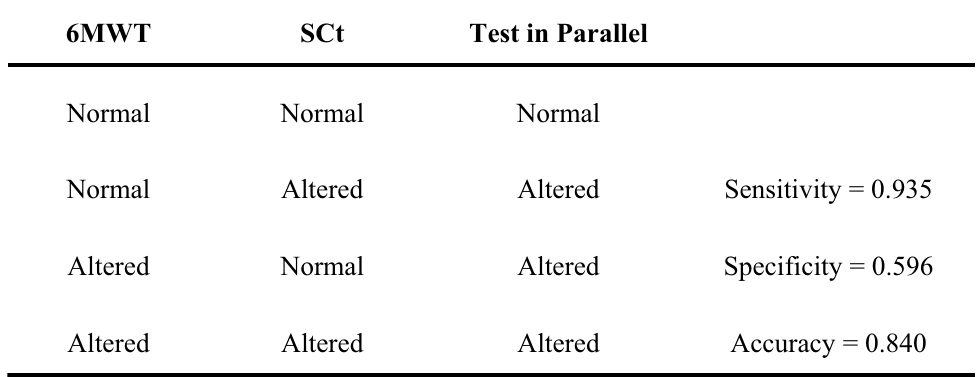
TABLE 4 - Parallel combination of the 6-minute walk test (6MWT) and Stair climbing time (SCt). Sensitivity, specificity, accuracy